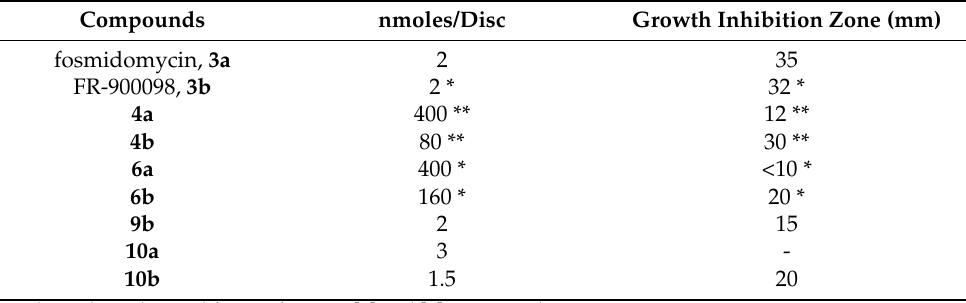
Table 2. E. coli XL1 Blue growth inhibition on LB solid medium.